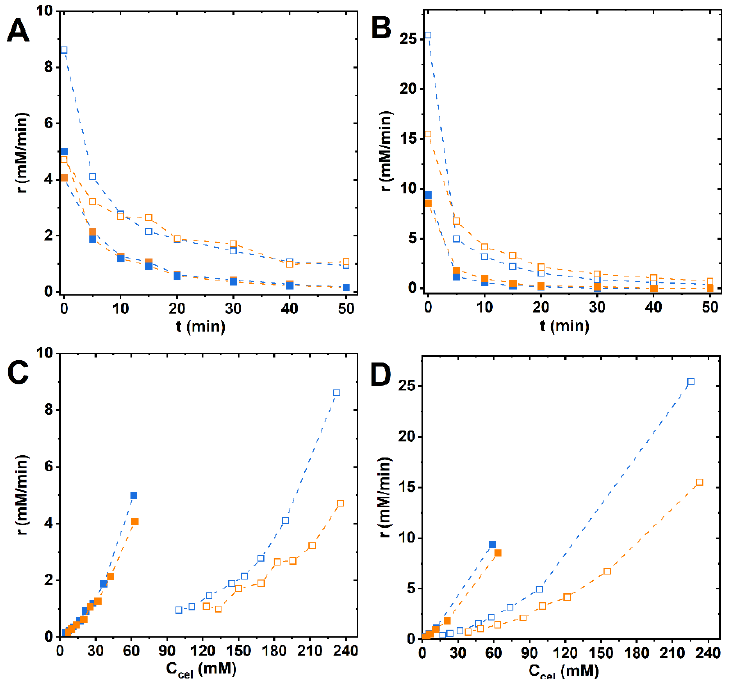
Figure 4. Evolution of the reaction time in the hydrolysis of cellobiose catalyzed by immobilized enzyme. Reaction rate vs. time in the batch reactor ( A , B ). Reaction rate vs. cellobiose concentration in the batch reactor ( C , D ). All data were obtained by the application of the differential method to the conversion time course of cellobiose catalyzed by different immobilized biocatalysts: Ag-Gly 2000 U _pNPG /g support (blue squares) and Ag-PEI 2000 U _pNPG /g support (orange squares), employing different cellobiose concentrations (sodium citrate buffer 50 mM pH 5.0): 20 g/L (filled squares) and 70 g/L (empty squares). The enzyme concentration employed was 0.90 U _pNPG /mL ( A , C ) and 4.50 U _pNPG /mL ( B , D ).